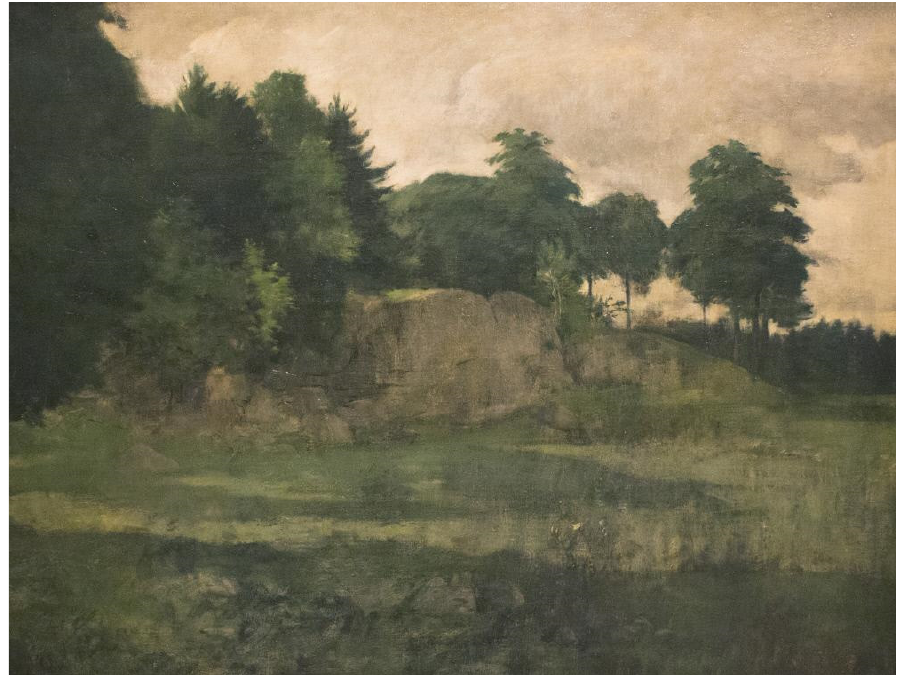
Figure 16. John Henry Twachtman, Landscape near Cincinnati (also titled Landscape ), ca. 1882, oil on canvas, 88.9 × 116.8 cm, Munson-Williams-Proctor Arts Institute, Utica, NY. Museum purchase, 58.9.